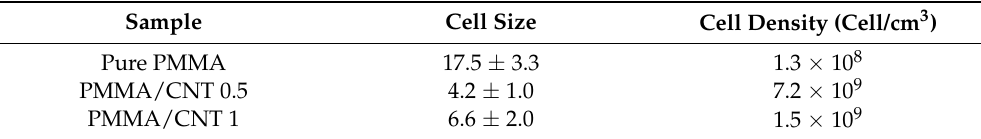
Table 2. Comparison of cell size and cell density of PMMA and PMMA nanocomposite foams